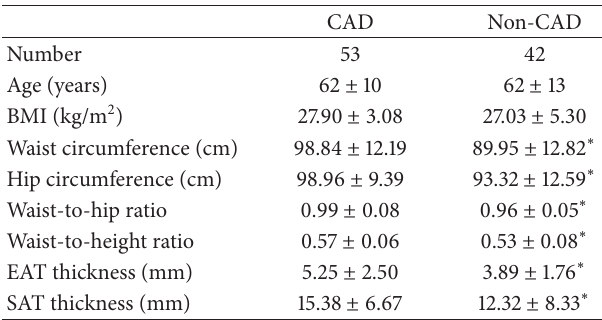
CAD: coronary artery disease; BMI: body mass index; EAT: epicardial adipose tissue; SAT: subcutaneous adipose tissue. ∗ 𝑝 < 0.05 :